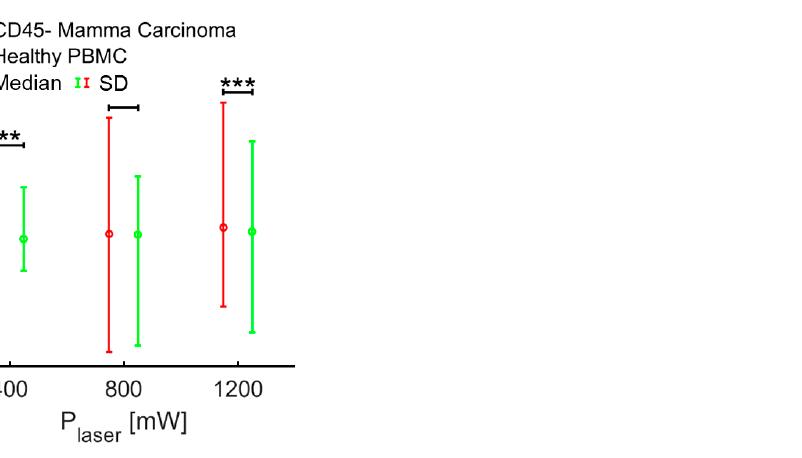
Figure 5. Shape restoration of cells in the optical stretcher. After being exposed to the laser-induced